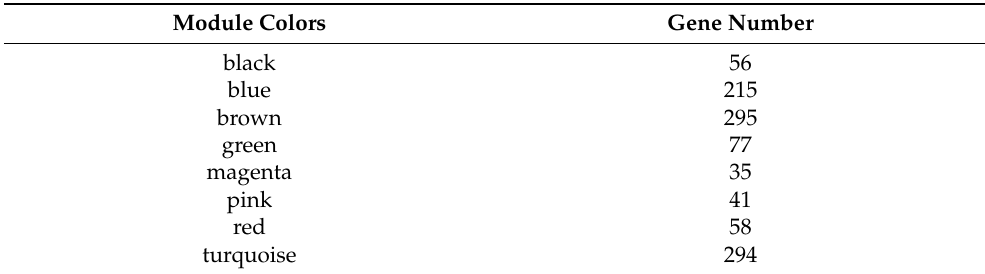
Figure 1. ( A ) Clustering of samples and determination of soft thresholding power. ( B ) Hierarchical dendrogram of genes. Eight modules were constructed, each decorated with a different color. ( C ) Visualizing gene co-expression network TOM. A light color represents a low overlap, and gradually darker red indicates high overlap. Table 2. Numbers of genes in the eight